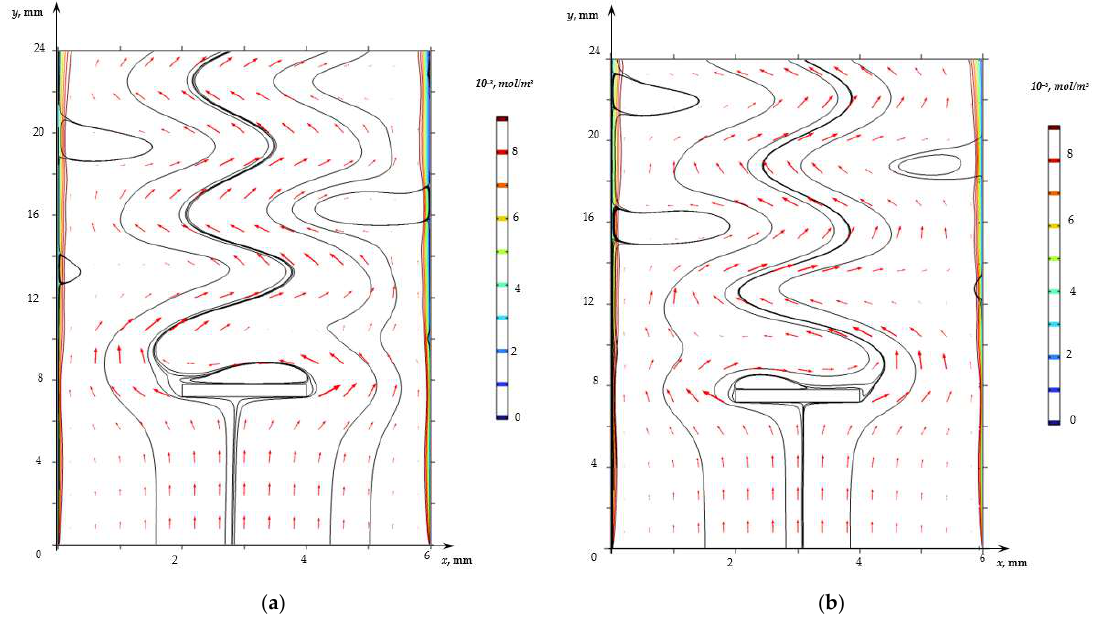
Figure 4. Electrolyte solution flow (black lines, arrows show the velocity field) and cation concentration distribution (colored level lines) for the desalination channel with spacer at time 170.65 s ( a ) and 170.70 s ( b ).